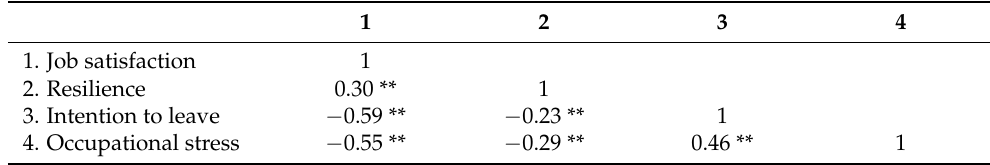
Table 2. Pearson’s r correlations between resilience, job satisfaction, intention to leave, and occupa- tional stress.